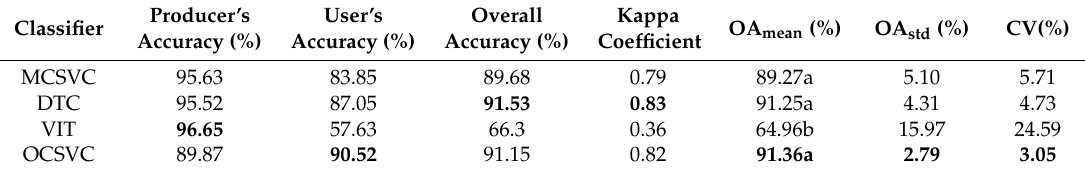
Table 5. Comparison of classification performance between the four methods.